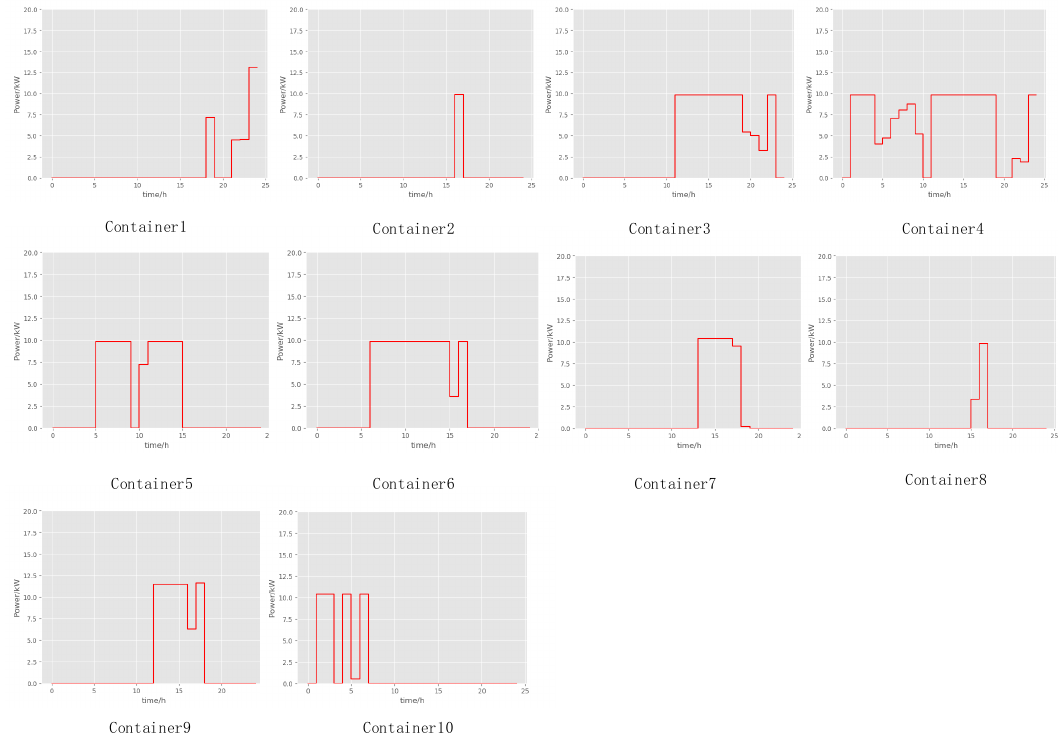
Figure 7. Frequency variation control strategy of containers with day-ahead optimization and control. Figure 8 is the result of aggregating the energy consumed by all containers in all timeslots. In the legend in Figure 8, flexibility represents emergency control, reallocate represents the DA module and finetune is the ID module. From the aggregated load curve, it can be seen that the energy consumption of the port used to control the internal temperature of the container under emergency has no time-series distribution law, and it changes completely according to the outdoor temperature change and the time of container entry. Therefore, this method cannot help the port save energy costs.